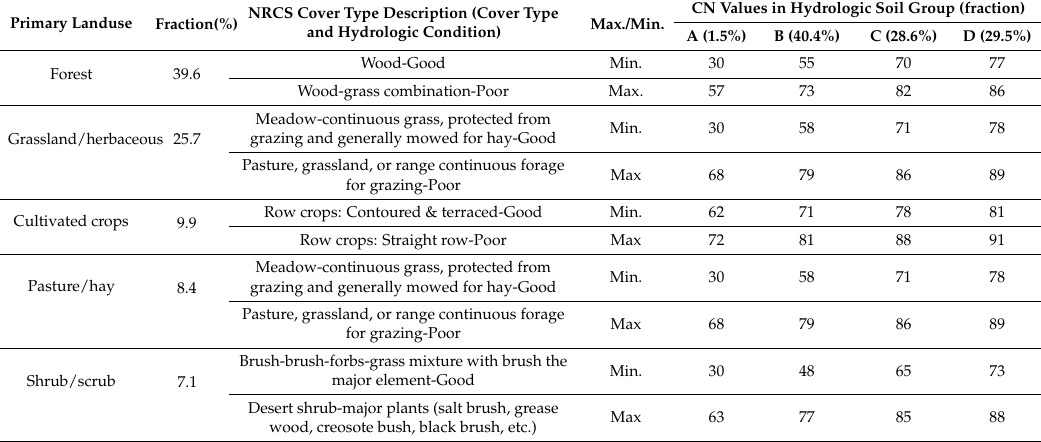
Table 1. Watershed land-use and hydrologic soil group area fractions, and min/max curve number (CN) values.